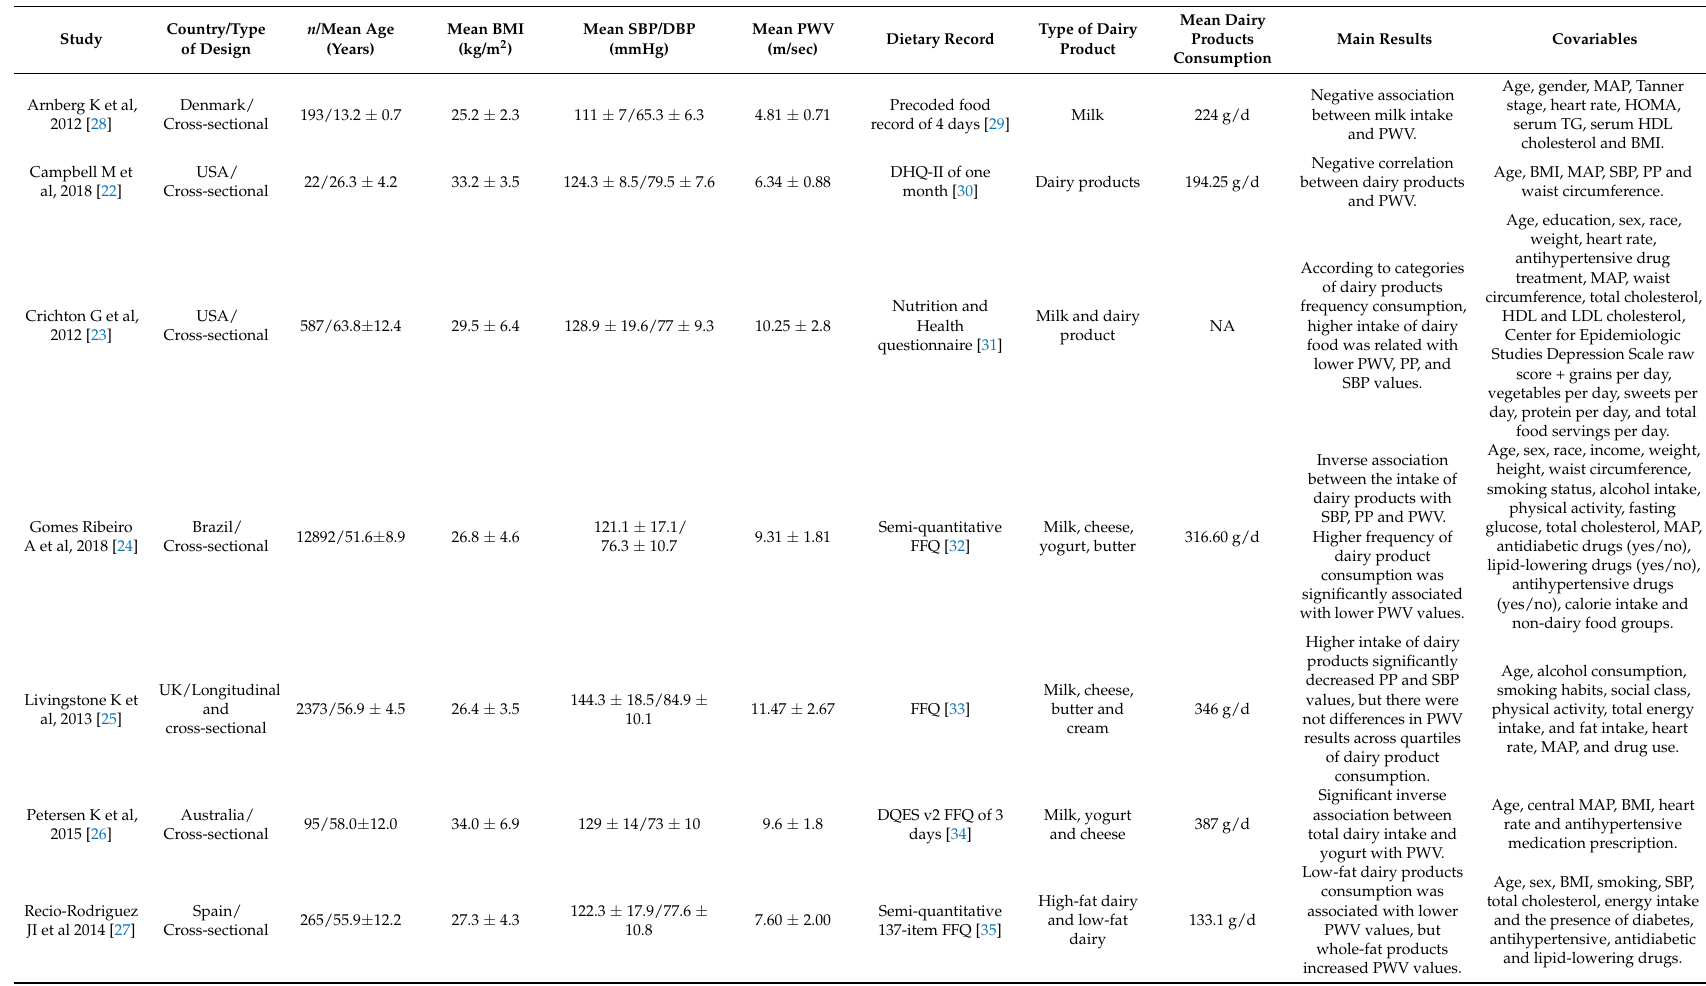
Table 2. Characteristics of the studies